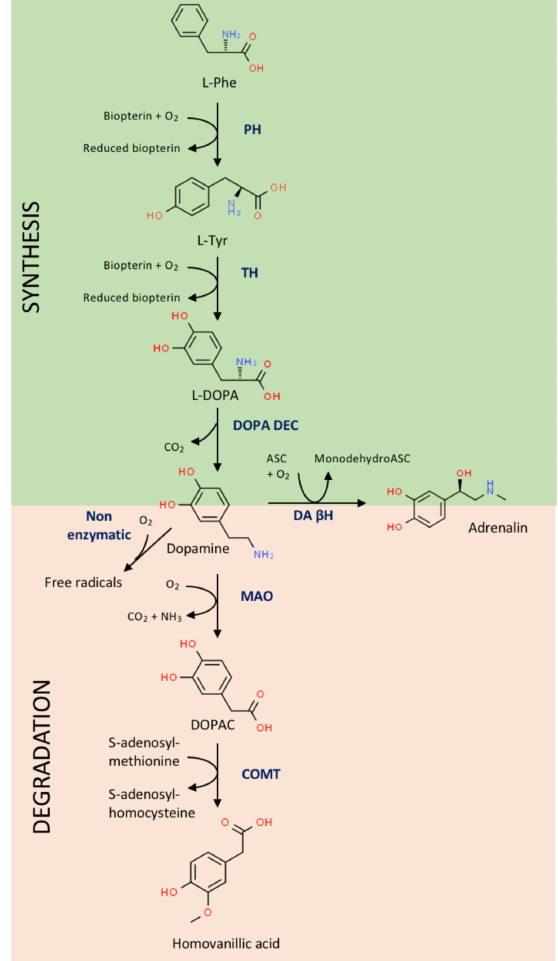
Figure 1. Dopamine synthesis and degradation pathways. ASC, ascorbic acid; COMT, catechol- o-methyltransferase; DA β H, dopamine β -hydroxylase; DOPAC, 3,4-dihydroxyphenylacetic acid; DOPA DEC, L-DOPA decarboxylase; L-DOPA, levo-dopa; L-Phe, L-phenylalanine; L-Tyr, L-tyrosine; MAO, monoamine oxidase; PH, phenylalanine hydroxylase; TH, tyrosine